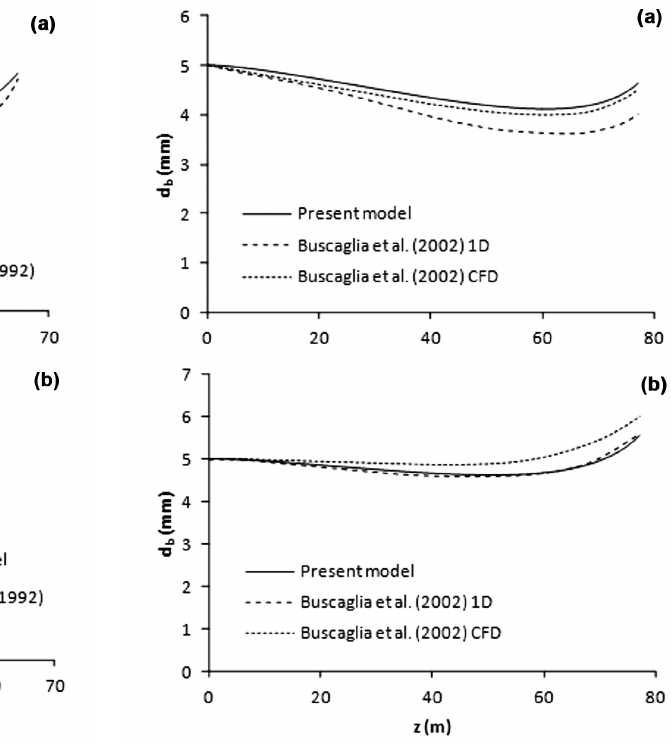
Figure 6 - Comparison between present model simulations and = 65 those of Buscaglia et al. (2002) considering both 1D integral d = 12 mm and Q = 0.014 and computational fl uid dynamics (CFD) models: initial b g,a = 2 mm and b